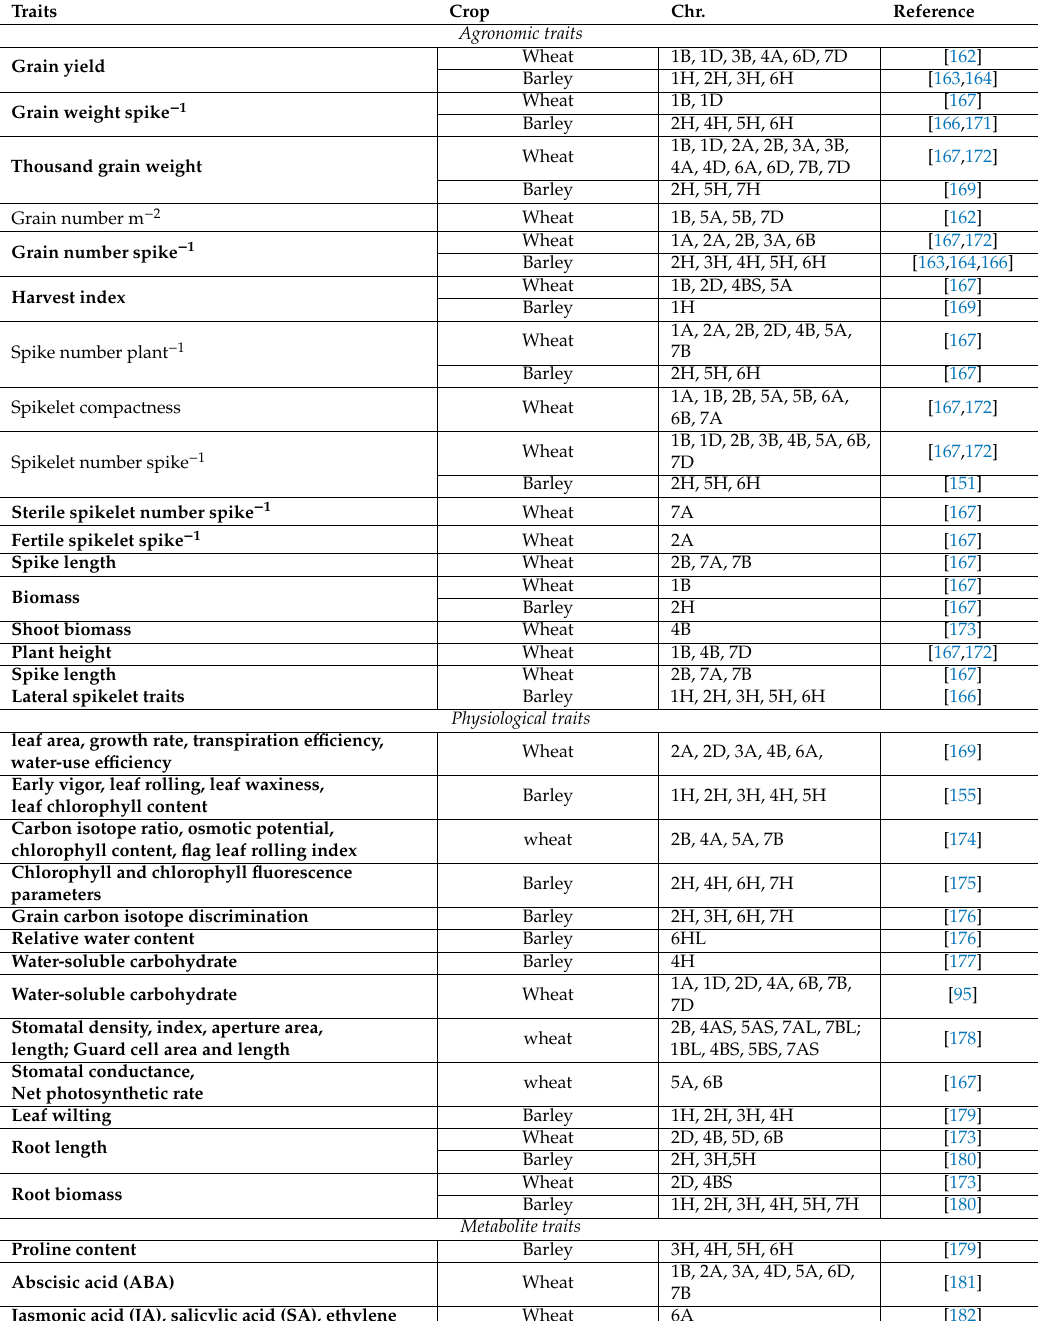
Table 2. The detected quantitative trait loci (QTLs) for agronomic, physiological and metabolite traits in wheat and barley using bi-parental mapping